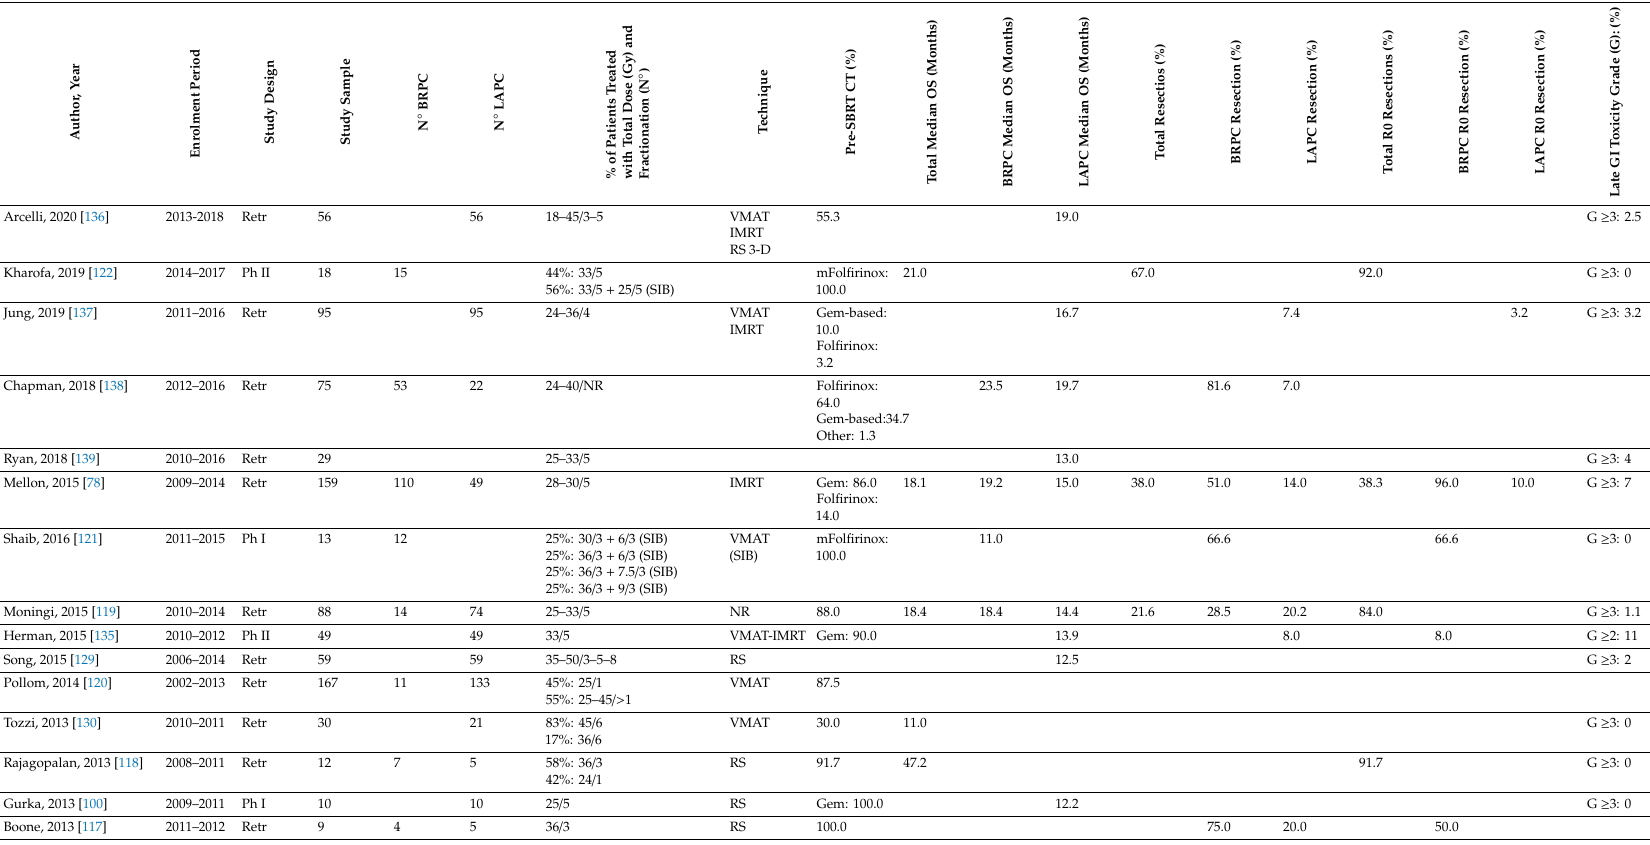
Table 4. Studies on stereotactic body radiotherapy in borderline resectable and locally advanced pancreatic